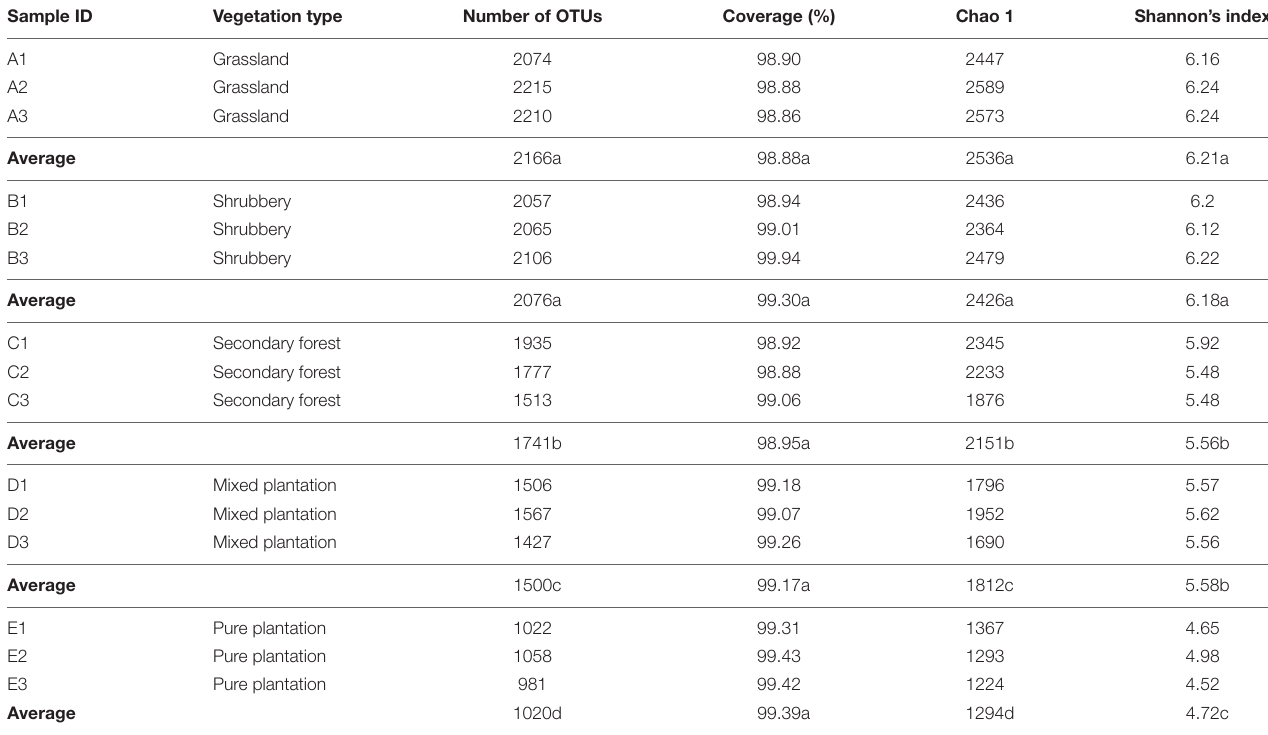
TABLE 2 | Characteristics of soil bacteria richness and diversity indices under different vegetation